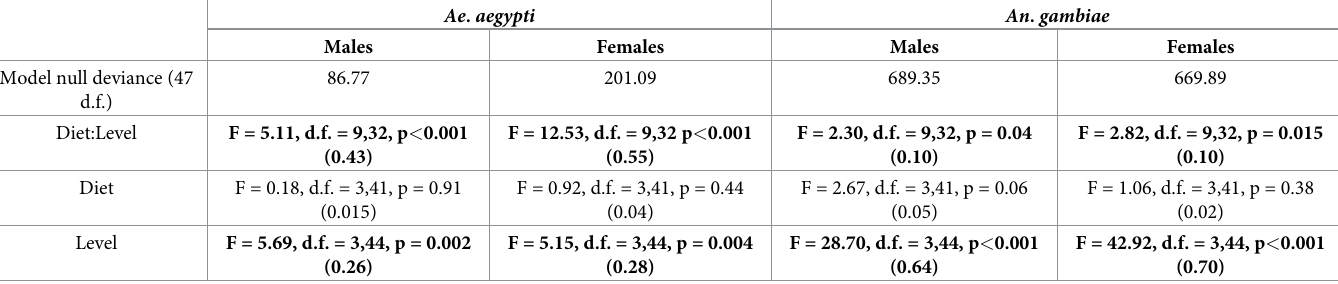
Table 2. Statistical summary of the influences on the number of male and female adults formed with the proportion of the deviance explained (in parentheses) given as an indicator of effect size (significant effects indicated in bold). Ae . aegypti Model null deviance (47 d.f.)